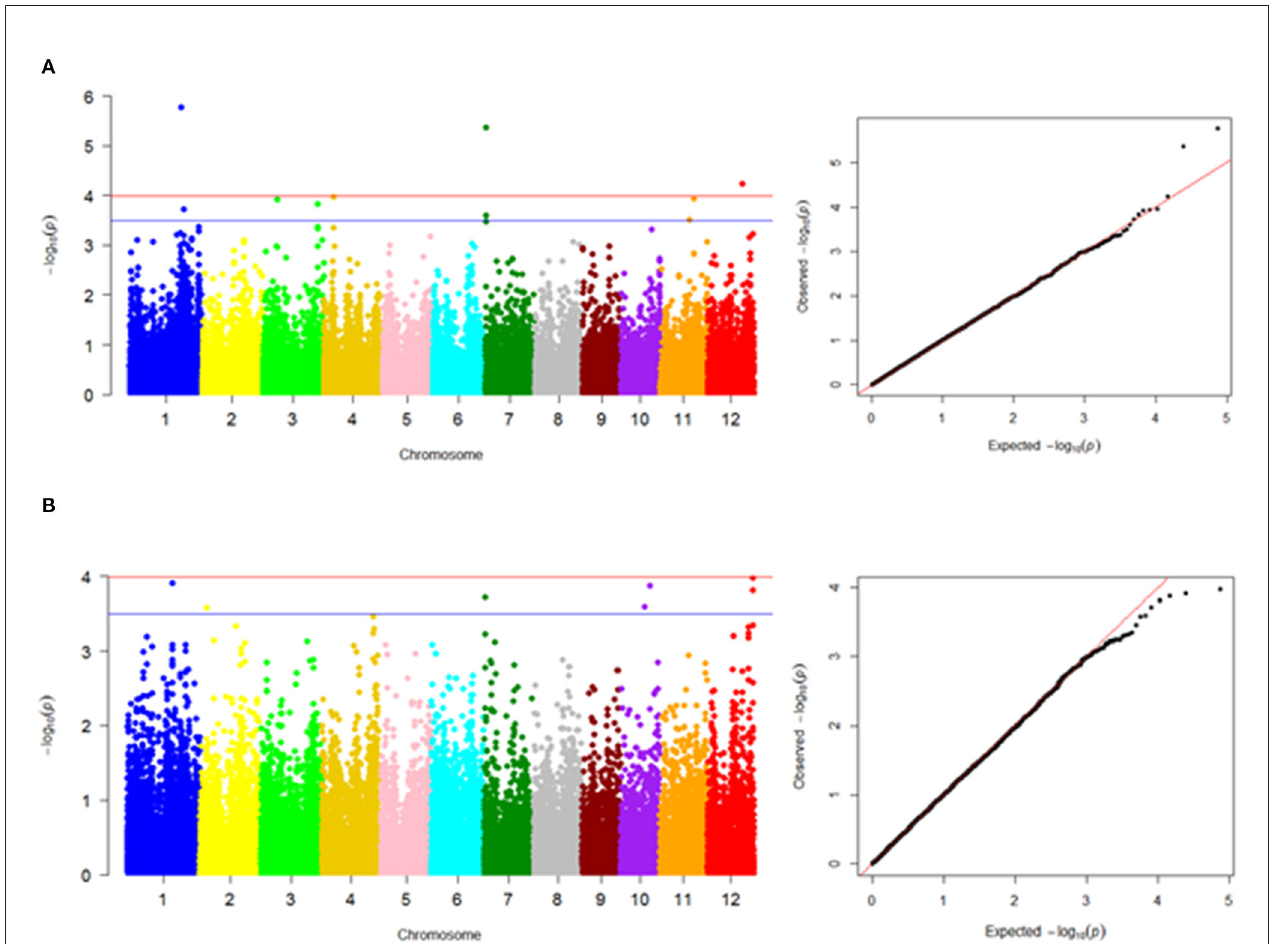
FIGURE 5 | Manhattan plots showing marker-trait associations in genome-wide association study results using the Fixed and Random Model Circulating Probability Unification (FarmCPU) model. (A) MLG content and (B) starch content. The –log10( p values) on the left scale of Manhattan plots are plotted against the position of SNPs on each of the 12 rice chromosomes. The Quantile–quantile plot (on the right) illustrates the distribution of expected vs. observed probability values, represented based on –log 10 ( p ). For MLG, four loci (on chromosomes 1, 4, 7, and 12) and for starch, one locus (on chromosome 12) were identified above the Bonferroni threshold (red line) correcting for genome-wide multiple tests at a type I error of 0.0001. The blue line on each Manhattan plot indicates significant marker-trait associations with –log 10 ( p ) >